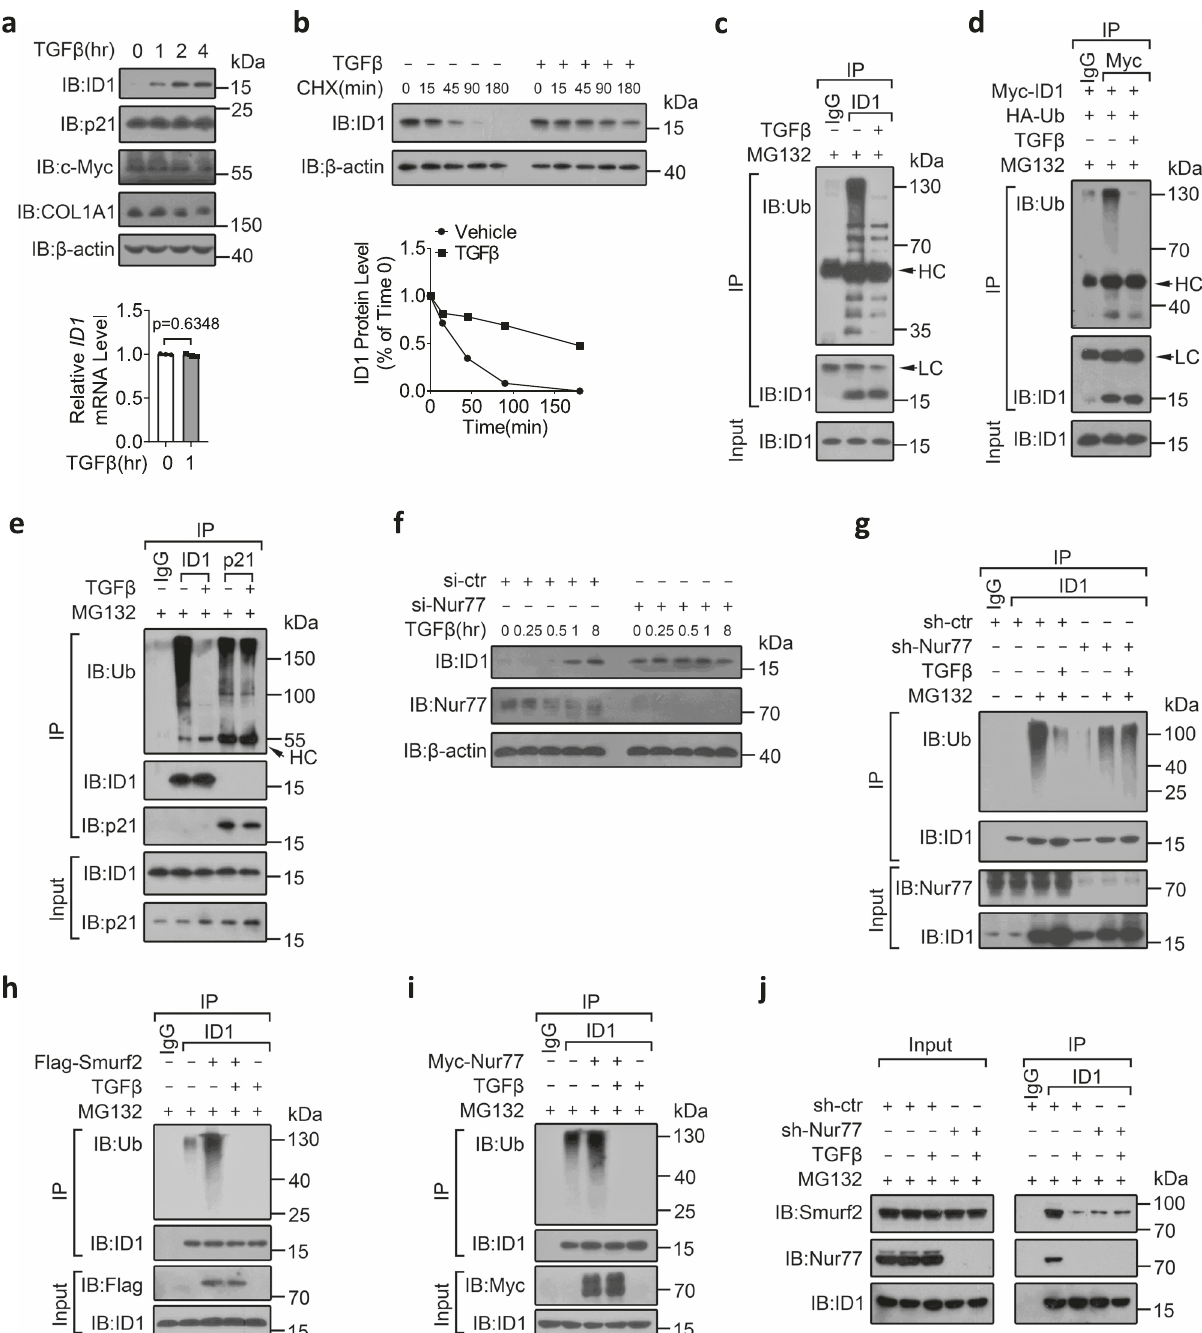
Fig. 4 TGF β stabilizes ID1 protein through preventing its Nur77-mediated interaction with and ubiquitylation by Smurf2. a SW620 cells were treated with TGF β (10 ng/mL) for the indicated time. IB and qRT-PCR were applied to examine protein and ID1 mRNA expressions, respectively. hr hour. Two- tailed unpaired Student ’ s t test were used for statistical analysis, and data are presented as means ± SD ( n = 3 biologically independent samples). b Cycloheximide (CHX) chase assay to determine ID1 turnover in the presence of TGF β (10 ng/mL) in SW620 cells. min minute. c – e , g – i SW620 cells were transfected with the indicated expression plasmids, siRNAs, or shRNAs followed by MG132 treatment for 2 h and then TGF β (10 ng/mL) treatment for 1 h. Protein ubiquitylation was examined by IP using the indicated antibodies and IB using anti-Ubiquitin (Ub) antibody. LC light chain, HC heavy chain, sh-ctr control shRNA, sh-Nur77 Nur77 shRNA. f SW620 cells were transfected with siRNAs before treatment with TGF β (10 ng/mL) for the indicated times. Protein expressions were examined by IB. si-ctr control siRNA, si-Nur77 Nur77 siRNA. j SW620 cells transfected with the indicated shRNAs were treated with MG132 for 2 h and then TGF β (10 ng/mL) for 1 h. Co-IP was applied to detect protein interactions. Data represent at least two independent experiments. Source data are provided as Source Data fi